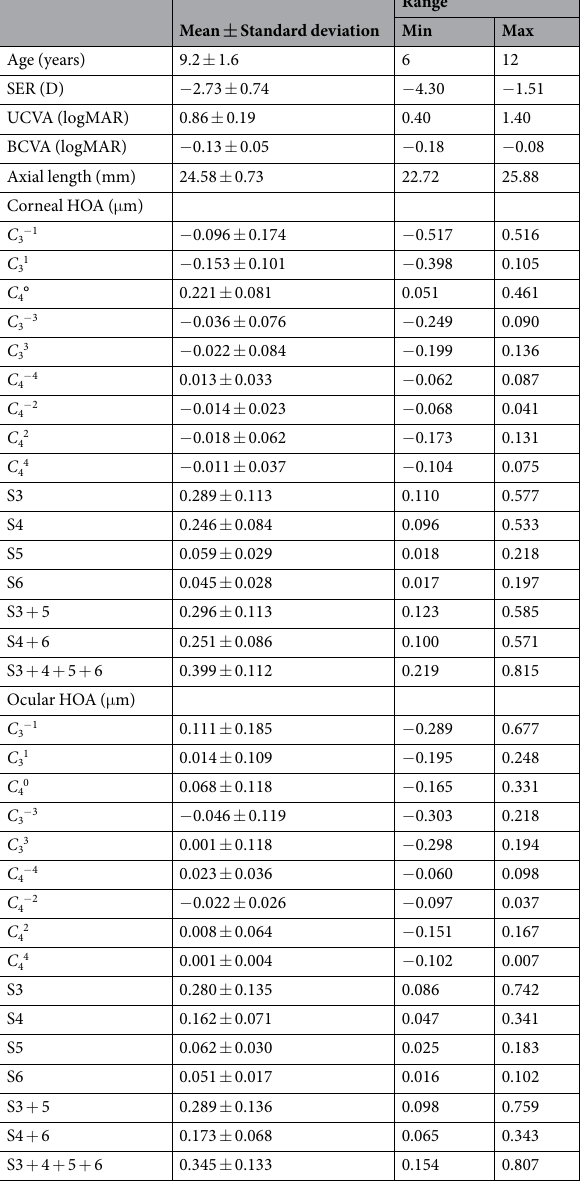
Table 1. Baseline demographic information and the corneal and ocular HOAs in those subjects who completed the 2-year examinations. SER = spherical equivalent refraction; UCVA = uncorrected visual acuity; BCVA = best-corrected visual acuity; logMAR = logarithm of the minimum angle of resolution; HOA = higher- order aberration; C 3 − 1 = vertical coma aberration; C 31 = horizontal coma aberration; C 40 = spherical aberration; C 3 − 3 , C 33 = trefoils; C 4 − 4 , C 44 = tetrafoils; C 4 − 2 , C 42 = secondary astigmatisms; S3 = 3rd-order RMS aberrations; S4 = 4th-order RMS aberrations; S5 = 5th-order RMS aberrations; S6 = 6th-order RMS aberrations; S3 + 5 = coma-like aberrations; S4 + 6 = spherical-like aberrations; S3 + 4 + 5 + 6 = total higher-order